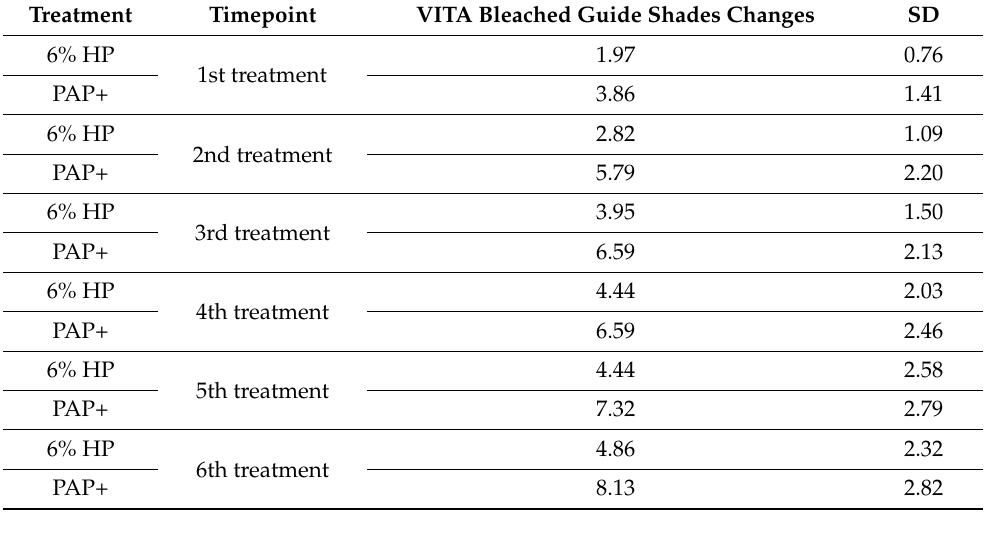
Table 2. Mean Post Treatment Changes in VITA ® Bleachedguide Shades.